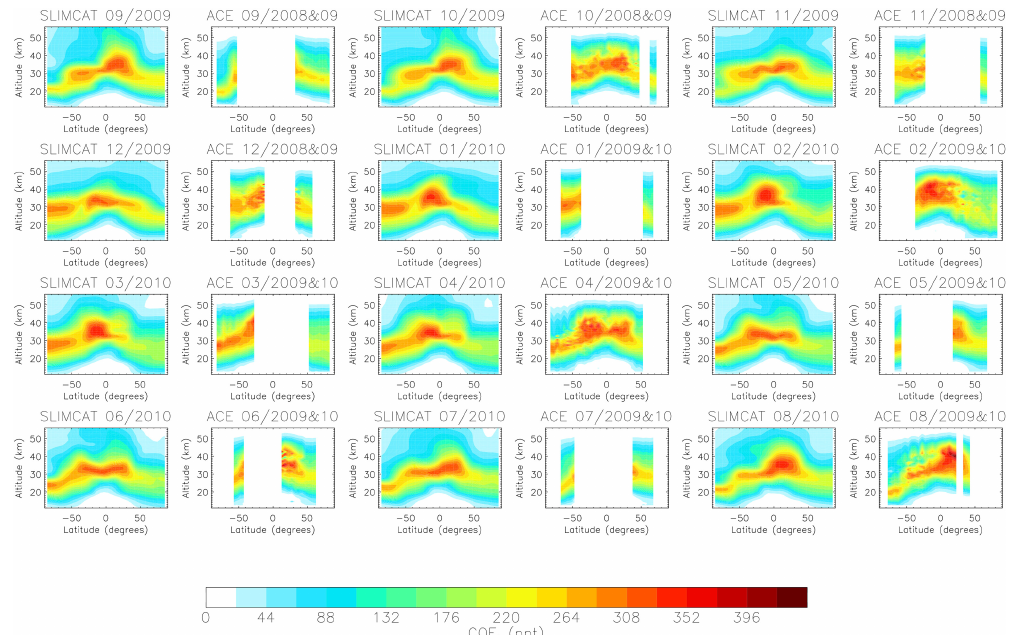
Figure 11. A comparison between monthly SLIMCAT and ACE zonal means (September 2009 to August 2010). In order to reduce the noise and increase the latitude coverage for the comparison, the plotted ACE data have been extended to the previous year. A full discussion of the seasonal variation in the COF 2 distribution is provided in the